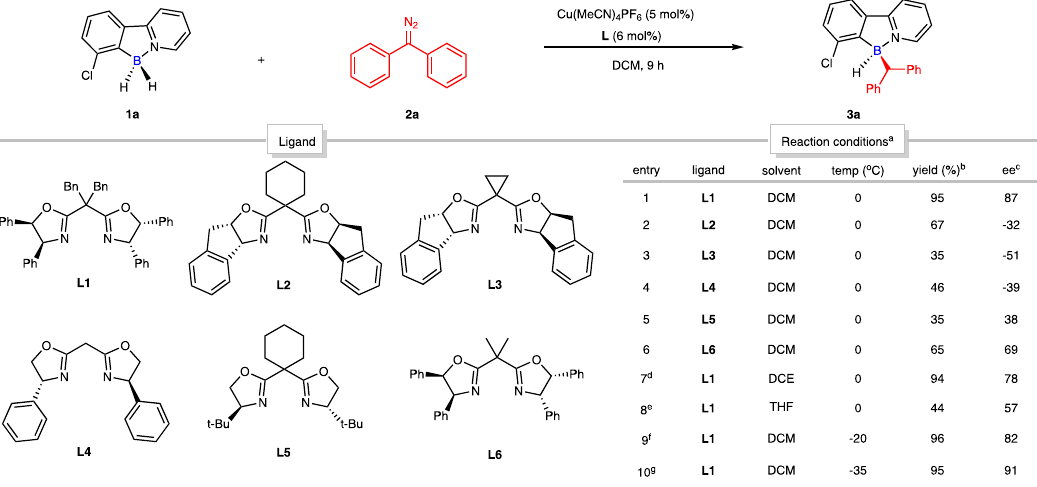
Fig. 4 Optimization of desymmetric B – H bond insertion reaction with (diazomethylene)dibenzene (2a). Conditions: a 7-Cl 2-phenylpyridine-borane ( 1a ) (0.1 mmol, 1.0 equiv), (diazomethylene)dibenzene ( 2a ) (0.12 mmol, 1.2 equiv), Cu(MeCN) 4 PF 6 (5 mol%), ligand (6 mol%), solvent (1 mL) at 0 °C for 20 h. b Isolated yield. c Determined by chiral HPLC. d DCE instead of DCM. e THF instead of DCM. f -20 °C instead of 0 °C. g -35 °C instead of 0 °C.